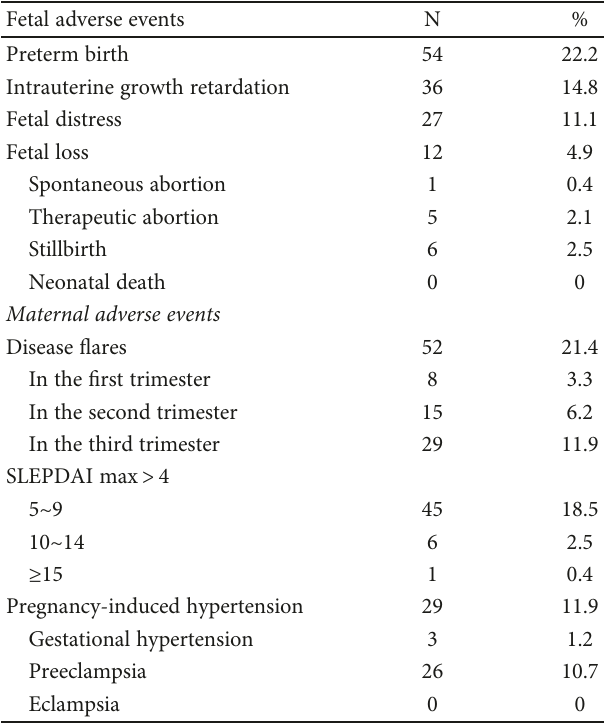
Table 1: Maternal and fetal outcomes in pregnant women with